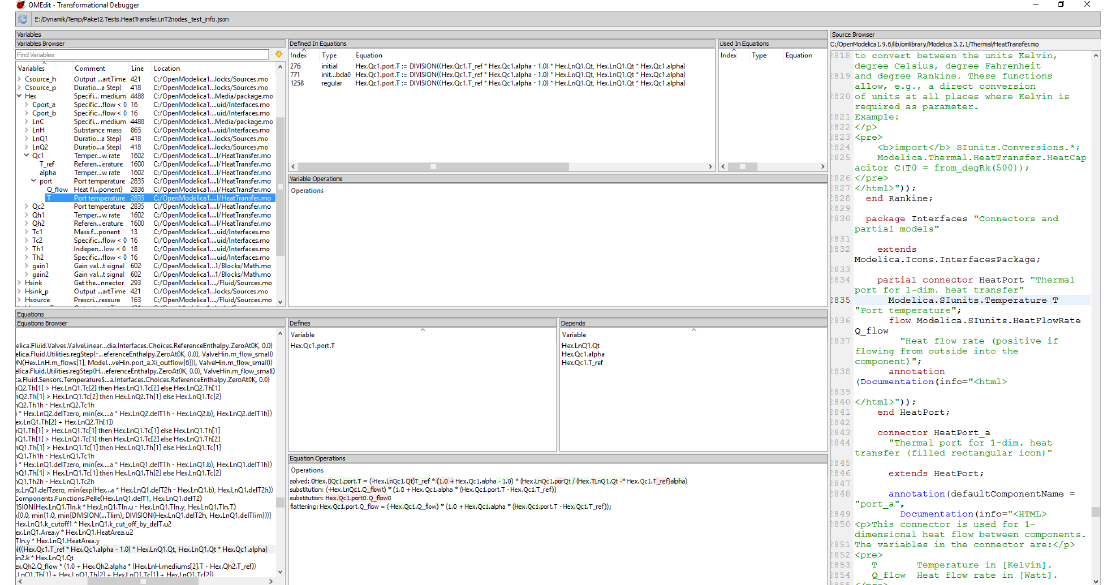
Figure 8: Information from the debugger variables